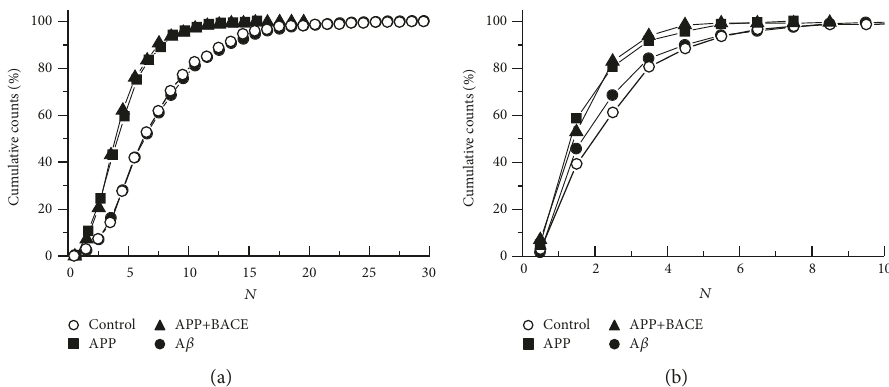
Figure 3: Muscle 4 neuromuscular junction. Cumulative probability of Bruchpilot cluster (active zone) distribution in individual synaptic boutons from transgenic Drosophila melanogaster larvae. (a) 1b boutons. (b) Satellite boutons. Control line — open circles; APP line — squares; APP+BACE line — triangles; and А β line — fi lled circles. The distribution of AZs per bouton in the APP and APP+BACE lines are signi fi cantly shifted toward fewer numbers compared to the control ( P < 0 01 , Kolmogorov-Smirnov test). In the А β line, cumulative probability is not signi fi cantly di ff erent from the control. N — active zone number per single